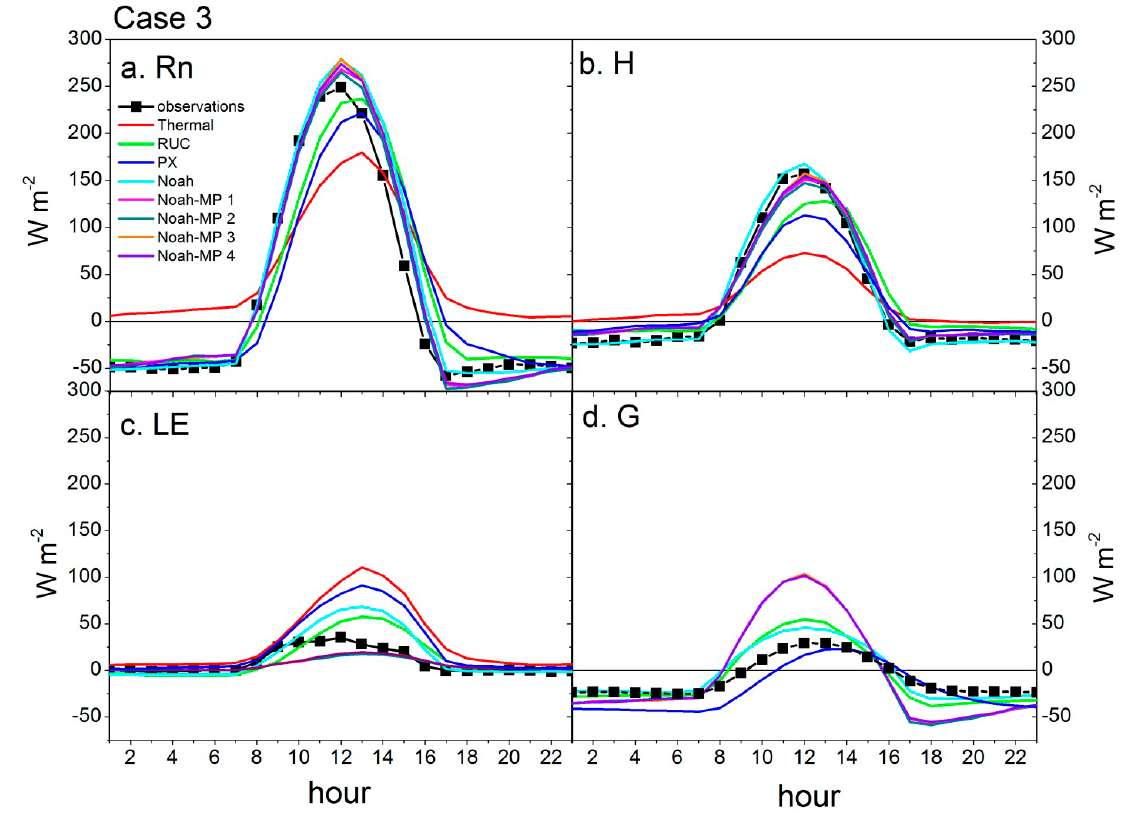
Figure 7. Mean diurnal plots of measured and simulated (a) net available energy (Rn), (b) sensible heat (H), (c) latent energy (LE), and (d) ground heat (G) fluxes for each LSM during Case 3 (November-December